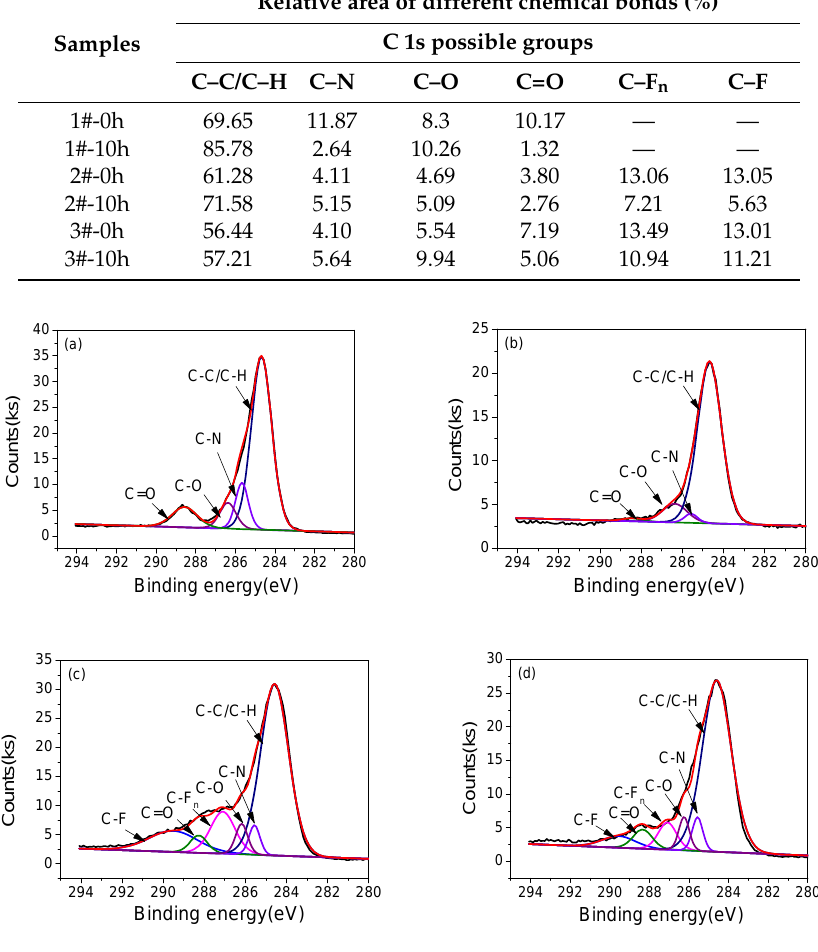
Table 2. Relative surface chemical bond content of the PI surfaces before and after plasma aging. Samples